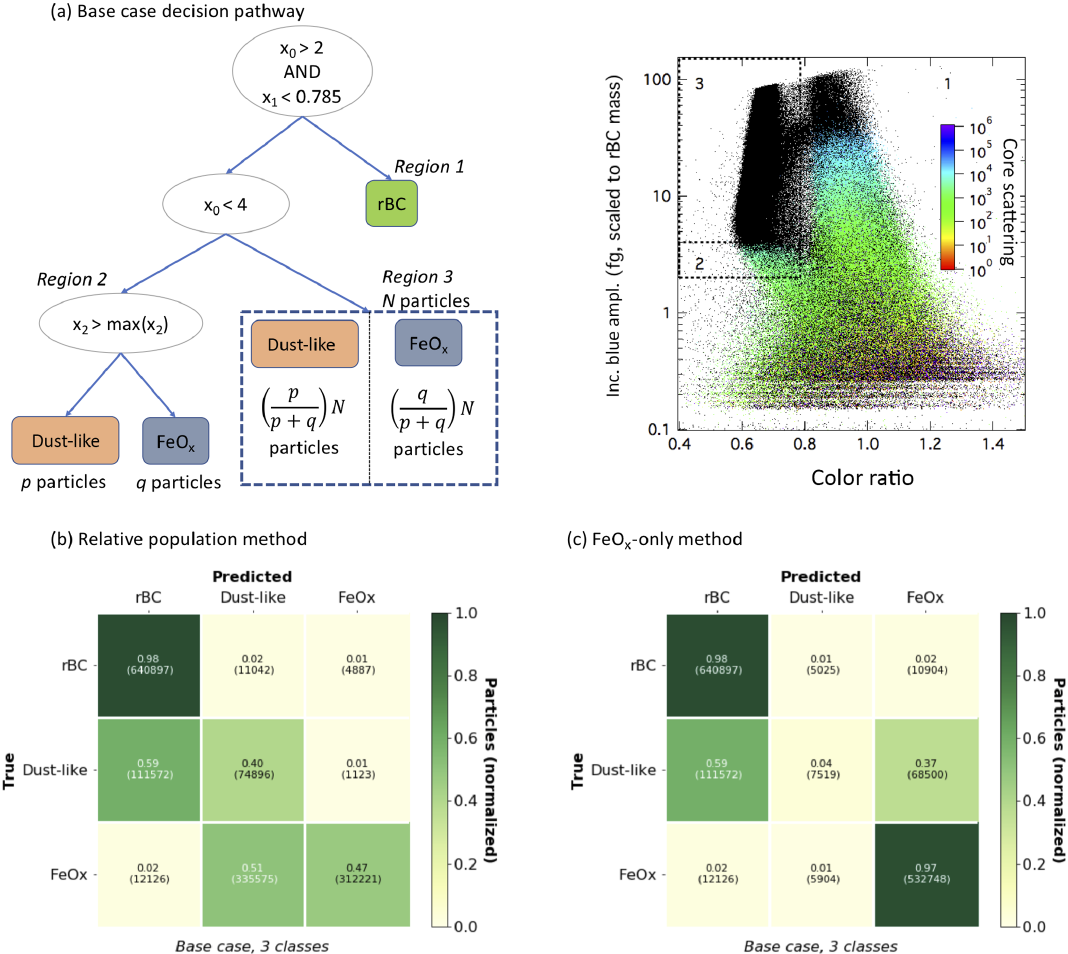
Figure 7. Base case classification scheme and confusion matrices. (a) We visualize the scheme for classifying aerosols using a simplistic pathway through feature space. The features are the same as in Table 2, and x 2 > max (x 2 ) indicates the detector is saturated for the core scattering measurement. The true case at each node corresponds to the left “child”. We need to make an additional assumption for the particles in the metallic mode that cannot be optically sized (the right-most split, corresponding to Region 3). Saturated values for core scattering are indicated by black dots in the right figure, which shows the incandescent peak height vs. color ratio for the laboratory samples. (b) Confusion matrix for the base case assuming the same ratio of anthropogenic FeO x :dust-like in Region 3 as measured in Region 2. Since the particles in Region 3 are differentiated only on a population basis to visualize this case as a confusion matrix we have made the additional assumption that particles are correctly classified up to the total number of aerosols of that class (any additional aerosols identified as that class are assumed to be false positives). (c) Confusion matrix for the base case identifying all aerosols in Region 3 as anthropogenic FeO x , to provide an upper limit on anthropogenic FeO x